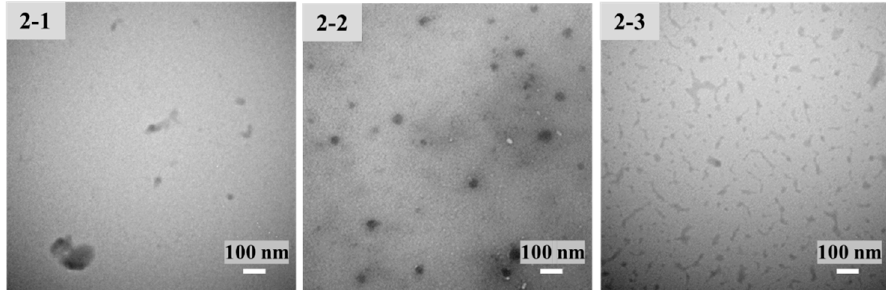
Figure 2. Transmission electron microscopy (TEM) images (at room temperature) of CS-NP-2-1, 2-2 and 2-3 in Table 1.